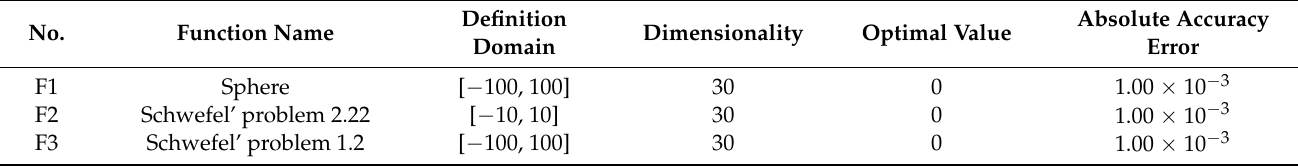
Table 2. Benchmark